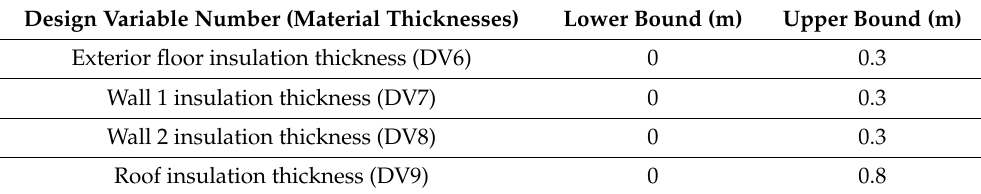
Table 4. The insulation material thicknesses and their ranges that are treated as continuous variables in the optimization.